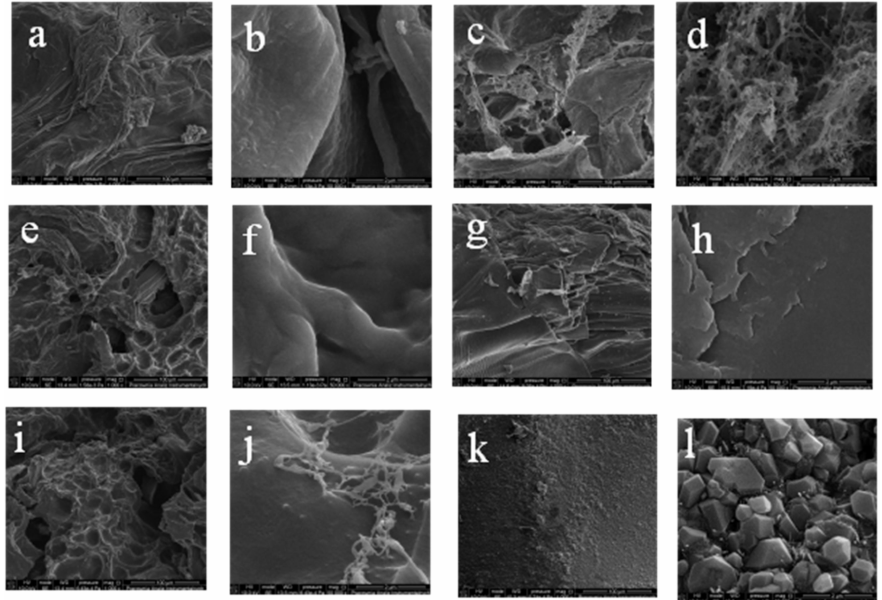
Figure 5. The SEM micrographs of ( a ) 1000 × magnification of CMS(1)/Ch(1) without the addition of vanillin; ( b ) 50,000 × magnification of CMS(1)/Ch(1) without the addition of vanillin; ( c ) 1000 × magnification of CMS(1)/Ch(1)/Van(0.04); ( d ) 50,000 × magnification of CMS(1)/Ch(1)/Van(0.04); ( e ) 1000 × magnification of CMS(1)/Ch(1)/Van(0.06); ( f ) 50,000 × magnifi- cation of CMS(1)/Ch(1)/Van(0.06); ( g ) 1000 × magnification of CMS(1)/Ch(1)/Van(0.08); ( h ) 50,000 × magnification of CMS(1)/Ch(1)/Van(0.08); ( i ) 1000 × magnification of CMS(1)/Ch(1)/Van(0.10); ( j ) 50,000 × magnification of CMS(1)/Ch(1)/Van(0.10); ( k ) 1000 × magnification of CMS; ( l ) 50,000 × magnification of CMS. Original full-scale images are included in the Supplementary